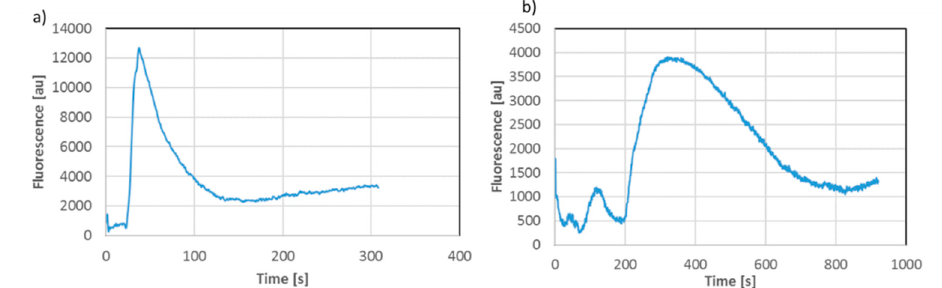
Figure 3. Blue methylene electrophoretic transport in the first microfluidic configuration ( a ) and after relocation of the sample to the second configuration ( b ), florescence measurement points are marked with arrows on Figure 2b.